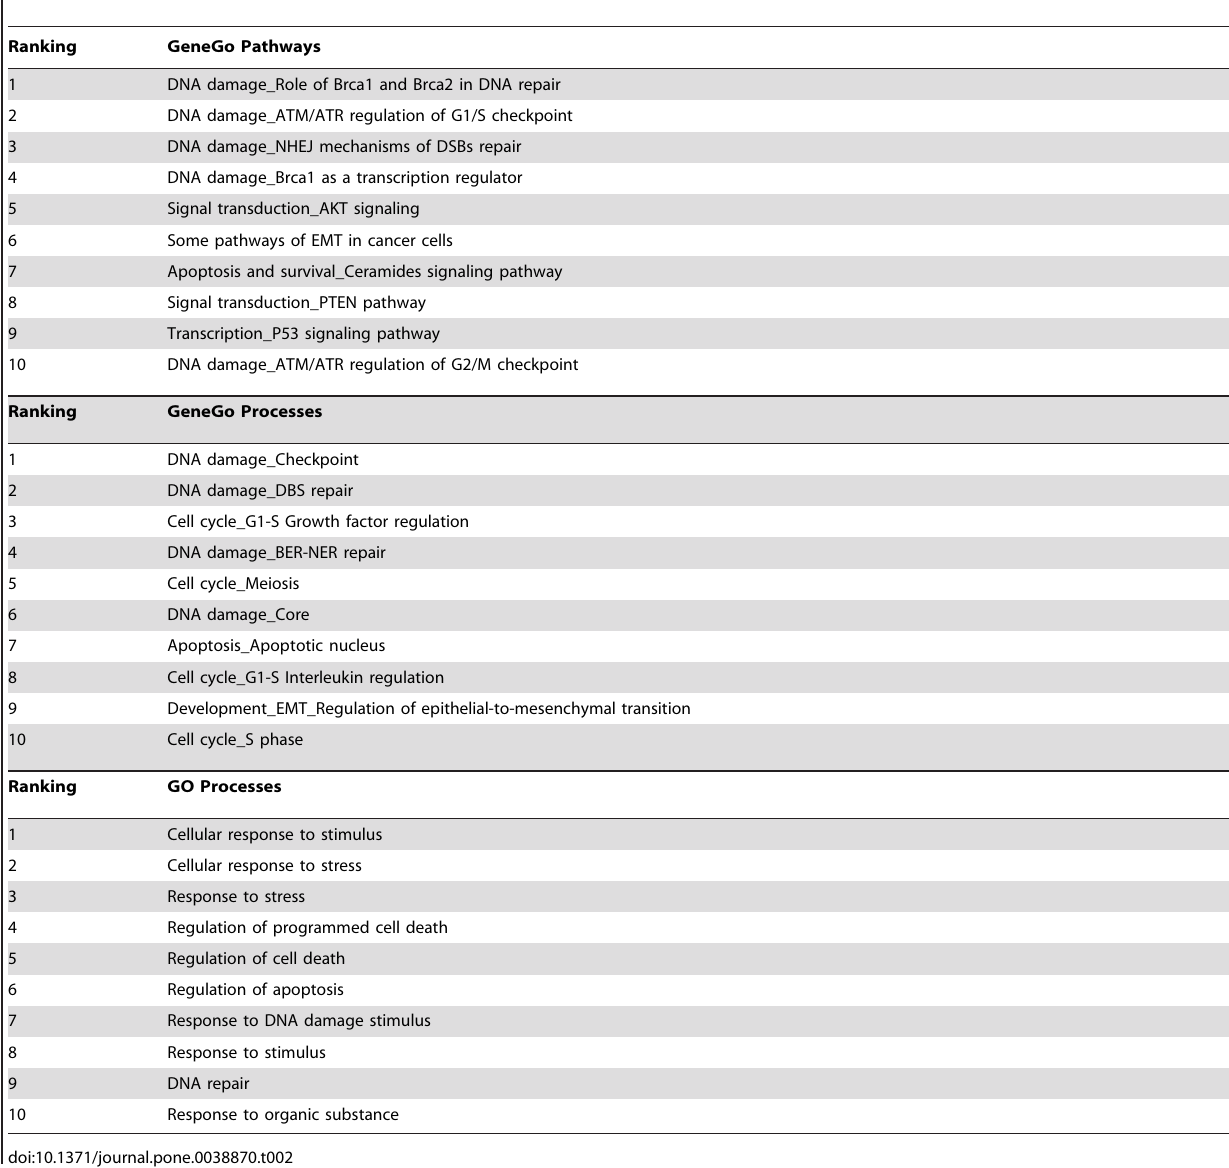
Table 2. The top ten GeneGo pathways/processes and GO processes resulting from genes identified via literature review.